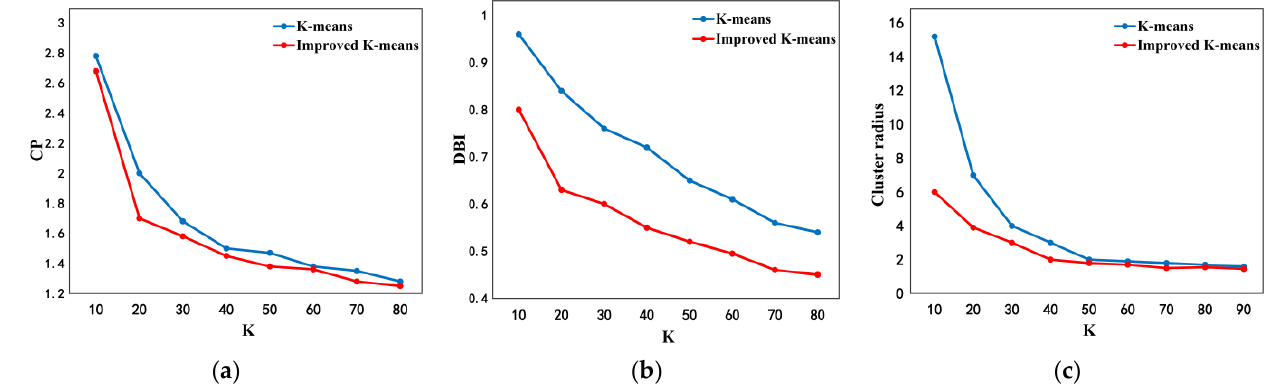
Figure 3. CP , DBI and Cluster Radius comparison results: ( a ) CP comparison; ( b ) DBI comparison; ( c ) Cluster Radius comparison.